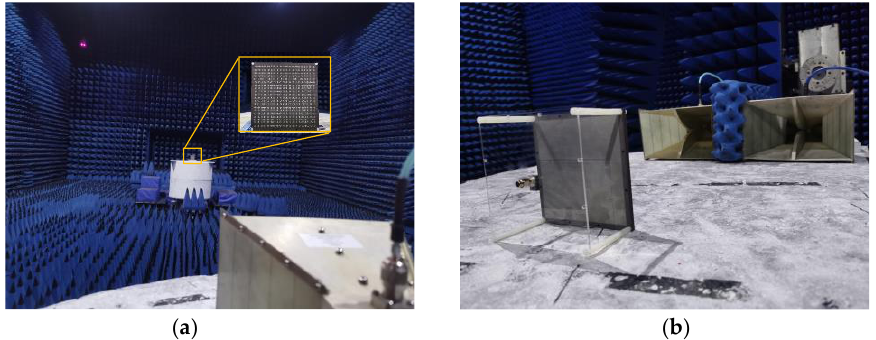
Figure 19. Measurement environment: ( a ) measurement of radiation performance; ( b ) measurement of scattering performance.